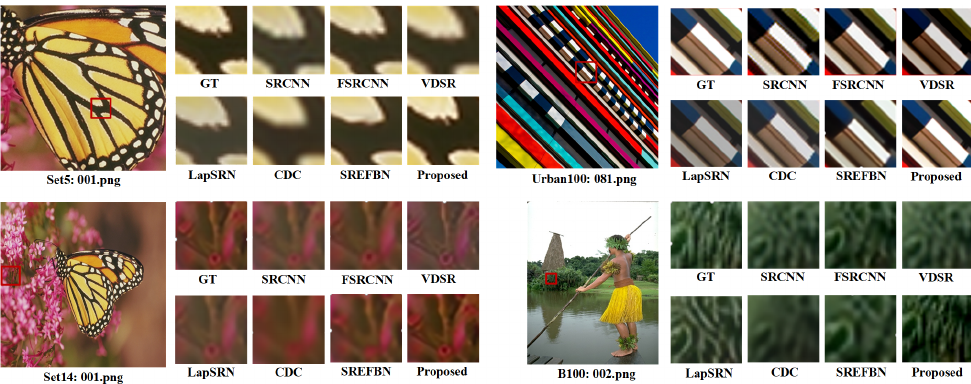
Figure 5. Visual comparisons with different methods for 2 × super-resolution on the Set5, Set14, B100, and Urban100 datasets.